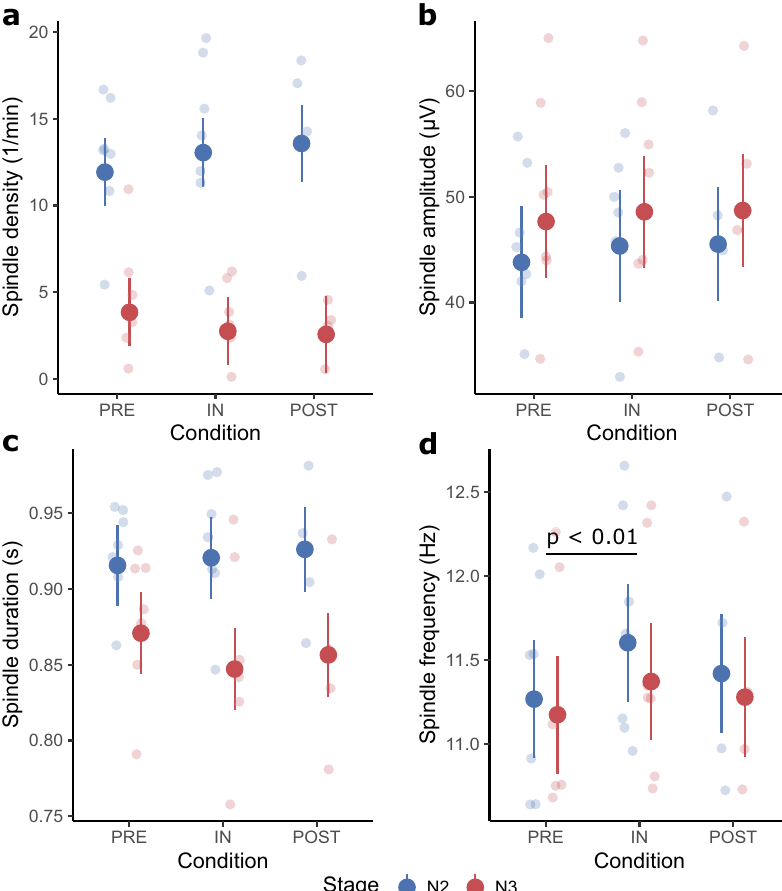
Fig. 4 Overall spindle characteristics. Large dots represent the estimated marginal means (± standard error) of each condition separated by sleep stage. The smaller dots in the background are individual data points in the respective condition and sleep stage. Signi fi cant differences (except between stages) are indicated by a black bar with an annotation stating the p -value. a Shows the overall spindle density. b Shows the overall spindle amplitude. c Shows the overall spindle duration. d Shows the overall spindle frequency with a signi fi cant difference between pre fl ight and in fl